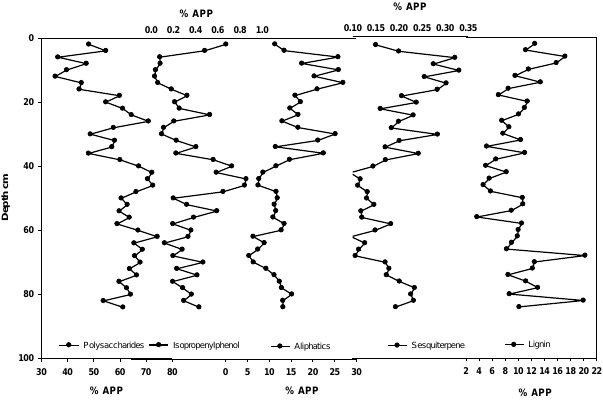
Figure 1: Distribution of selected (groups of) pyrolysis products in the KK peat record 2 Figure 1. Distribution of selected (groups of) pyrolysis products in indicative for polysaccharides, aliphatics and lignin, the markers of Sphagnum (4-3 the KK peat record indicative for polysaccharides, aliphatics and Isopropenylphenol) and Pinus (sesquiterpene). Values show percentages of bulk samples 4 lignin, the markers of Sphagnum (4-Isopropenylphenol) and Pinus relative to the sum of all quantified pyrolysis products (APP). 5 (sesquiterpene). Values show percentages of bulk samples relative to the sum of all quantified pyrolysis products (APPs).